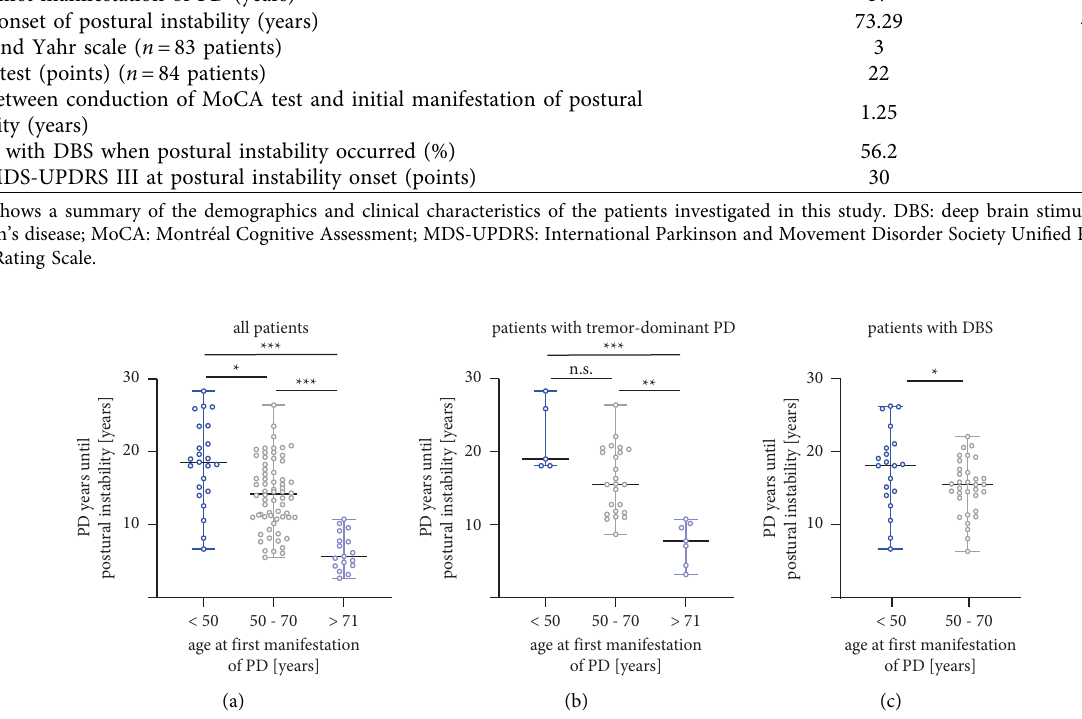
Figure 2: Onset of postural instability occurs later in the disease course in patients with early manifestation of PD. (a) Patients with onset of PD < 50 years ( n � 23 patients, left) have on average 18.6 (median; range: 6.7–28.3) PD years before the onset of postural instability. Tis time is signifcantly diferent compared to patients with PD onset at 50–70 years (middle, n � 66 patients, median:14.2 years, range: 5.5–26.4) and > 70 years (right bar, n � 17, median: 5.6 years, range: 2.7–10.8 years); (b) From the graph in (a), only the tremor-dominant patients were selected. Patients with onset of PD < 50 years ( n � 5 patients, left) have median 19 (range: 18.8–28.33) PD years before onset of postural instability. Tis is not diferent compared with patients with frst manifestation between 50 and 70 years (middle, n � 24 patients, median: 15.5 years, range: 8.67–26.42) but both groups are signifcant diferent to manifestation of PD > 70 years (right bar, n � 7, median: 7.8 years, range: 3.2–10.8 years); (c) From the graph in (a), only the patients treated with DBS were selected. Patients with manifestation of